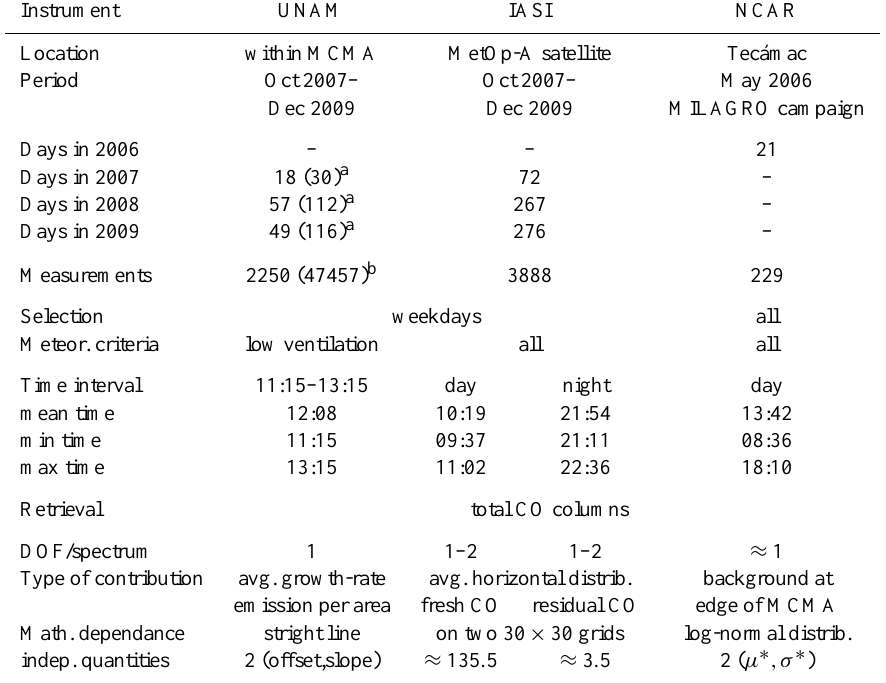
Table 1. Overview of the CO column measurements from the three FTIR instruments used for the top-down emission estimation. Instrument UNAM IASI Location within